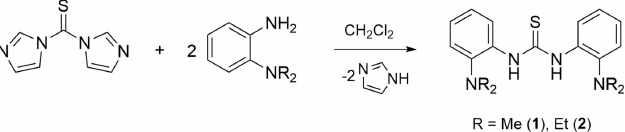
Figure 5 Preparation of N , N 0 -bis(2-dimethylaminophenyl)thiourea ( 1 ) and N , N 0 - bis(2-diethylaminophenyl)thiourea ( 2 ).